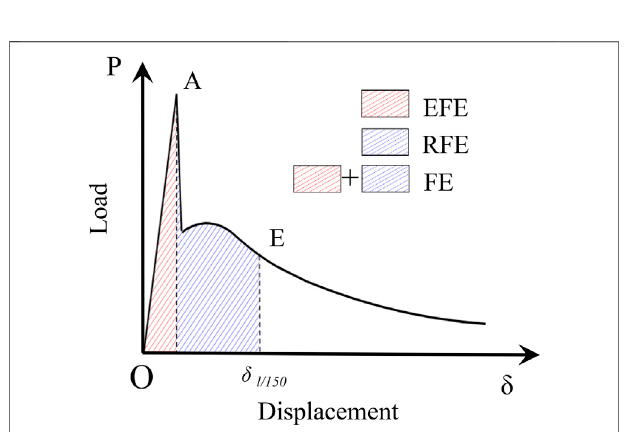
FIGURE 3 | Schematic of energy